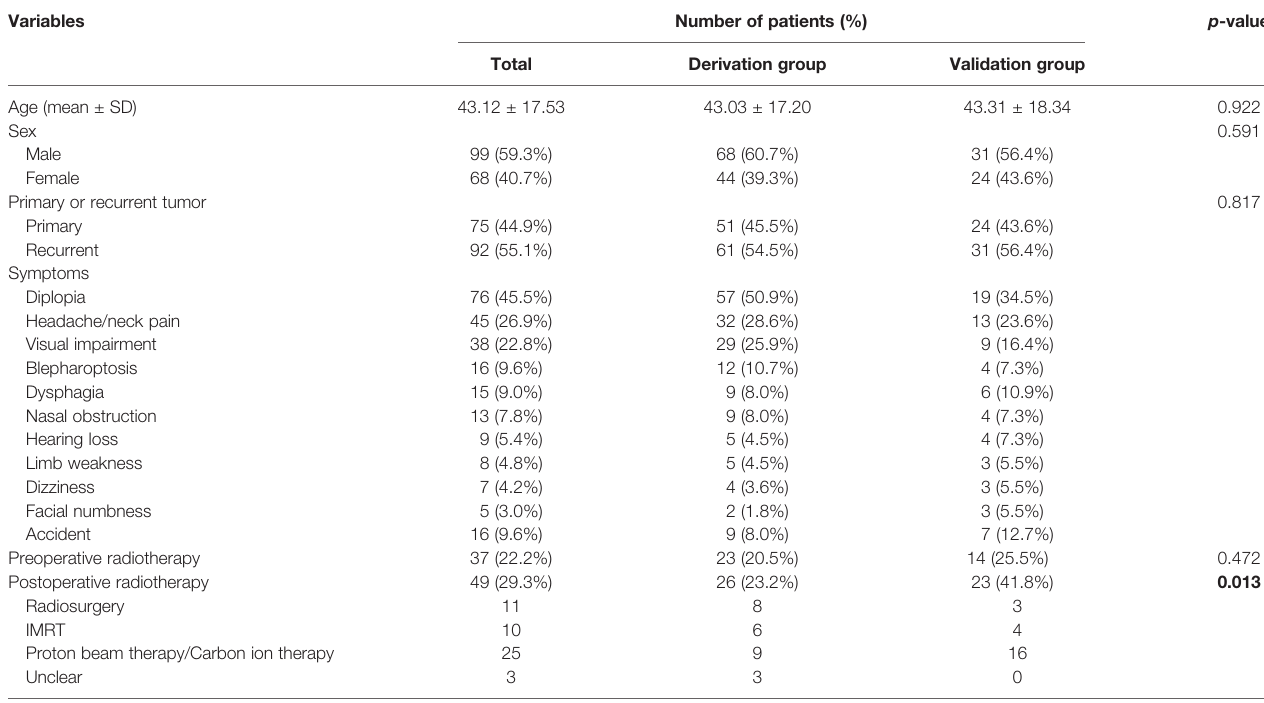
TABLE 1 | Demographic and clinical characteristics of skull base chordoma patients.